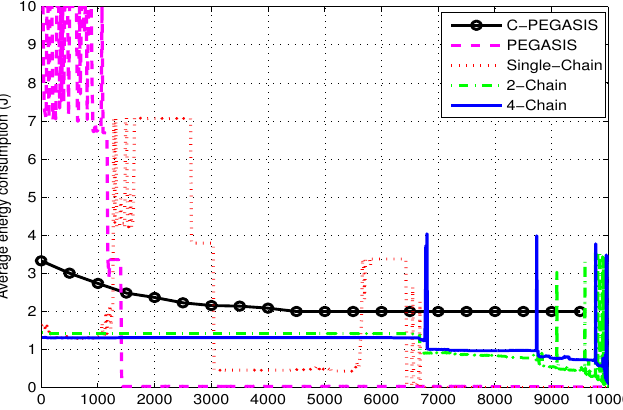
Figure 13. Average energy consumption (J) in 4-chains, 2-chains, single-chain based routing and PEGASIS.